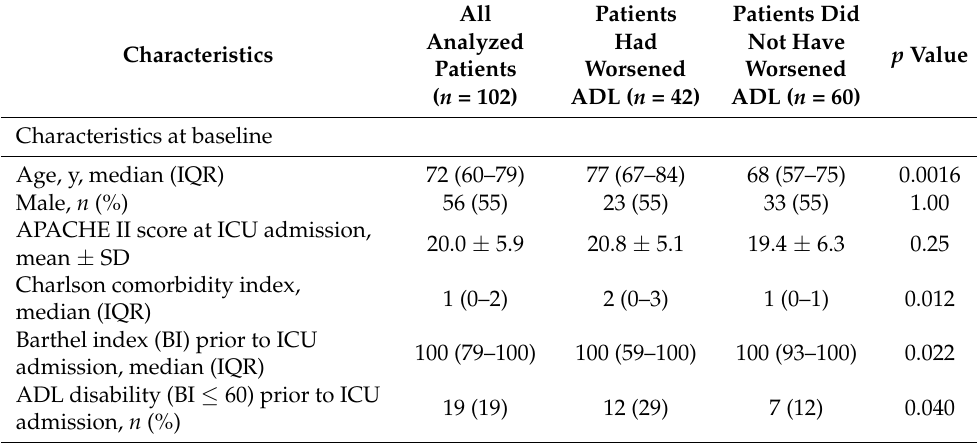
Figure 1. Flowchart of the patients. ICU: intensive care unit. Table 1. Patient characteristics.